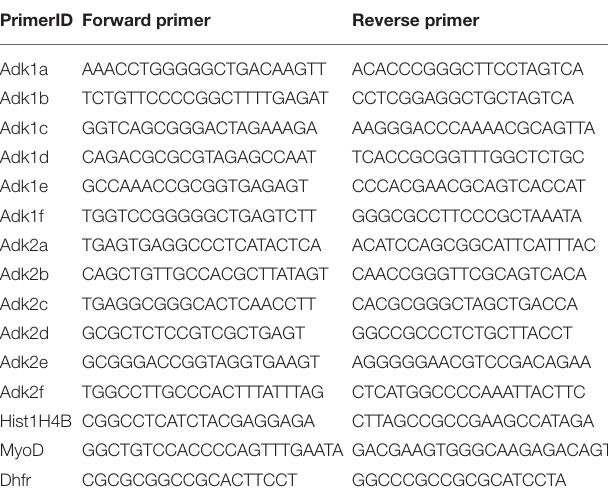
TABLE 1 | Genomic DNA primers used for quantitative real-time PCR to amplify immunoprecipitated